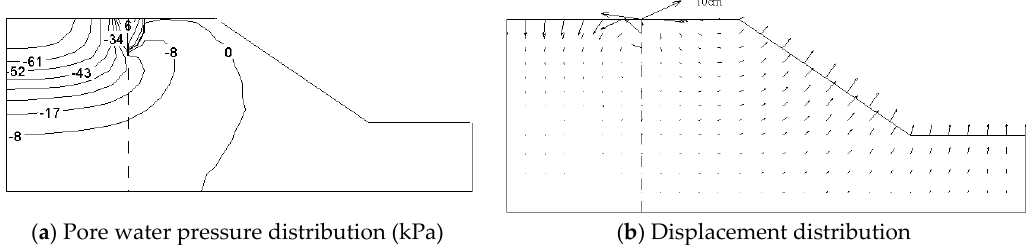
Figure 5. The distributions of pore water pressure and displacement at the end of rainfall of baseline group.